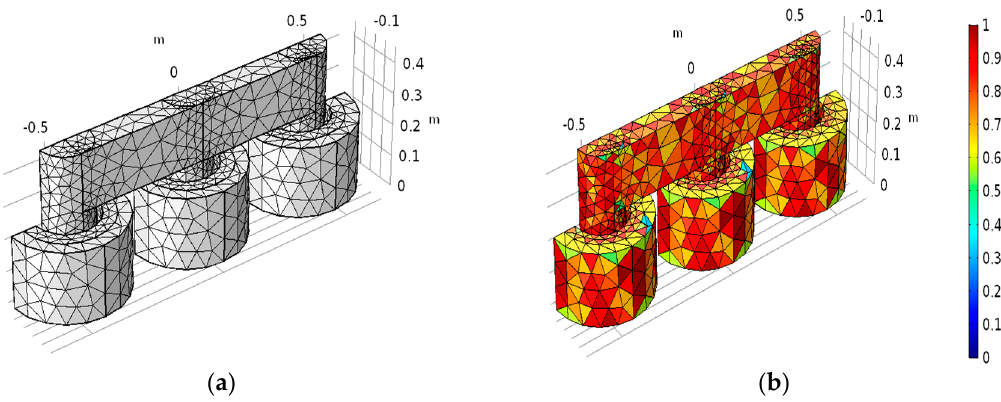
Figure 5. ( a ) Mesh-generation results of geometric model; ( b ) quality diagram of grid division. Table 2. Main parameters of the SCB10-1000/10 dry-type transformer coil structure.